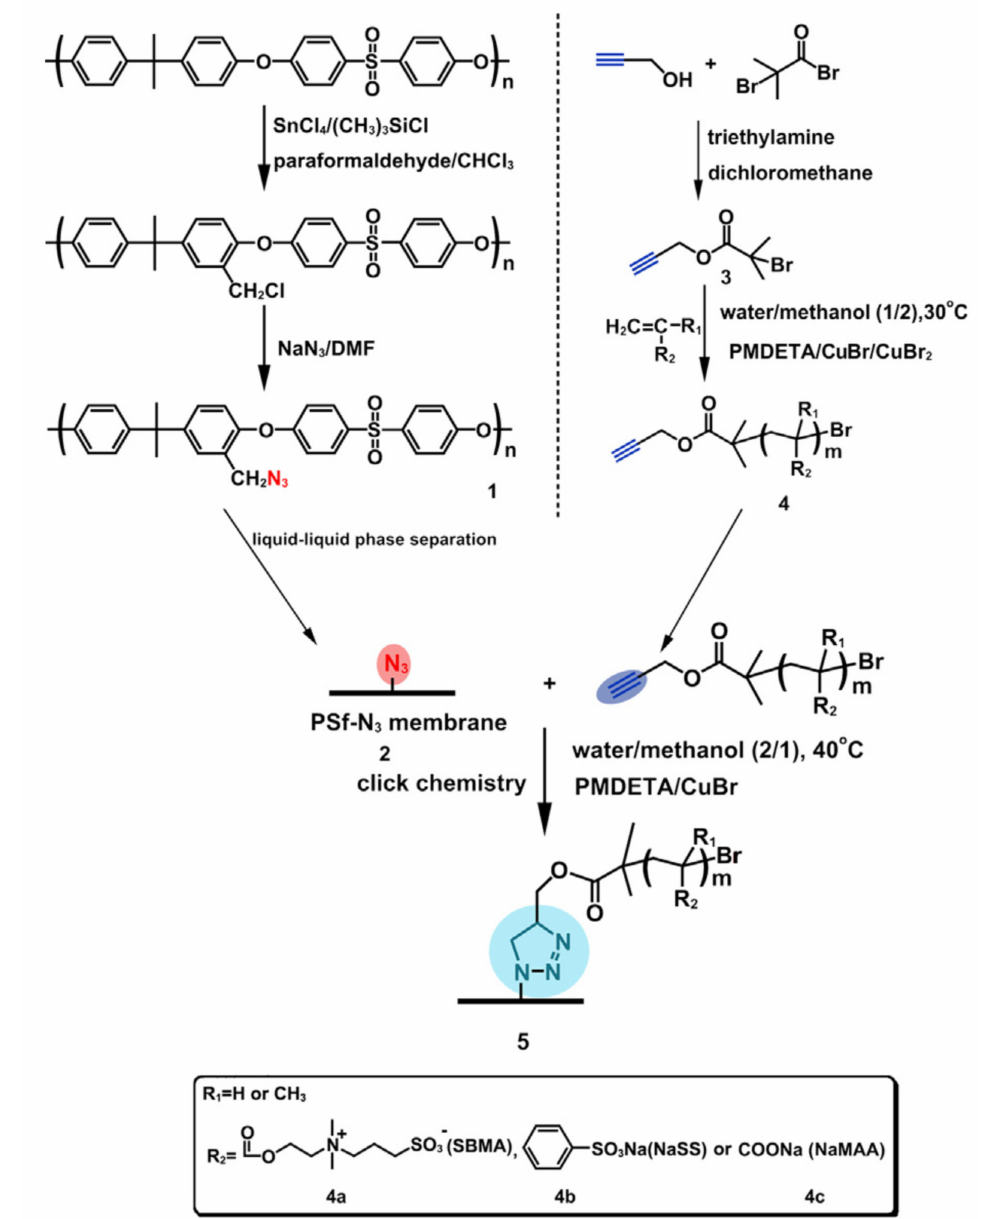
Figure 8. Synthesis of functionalize azido-polysulfone, alkynyl-functionalized polymers and grafted polysulfone membrane via click chemistry (reproduced with permission after